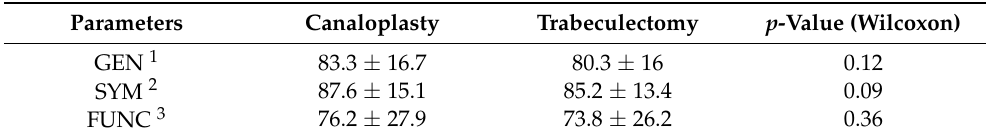
Table 2. Glaucoma Symptoms Scale (GSS) questionnaire: a comparison between canaloplasty and trabeculectomy through the Wilcoxon test.